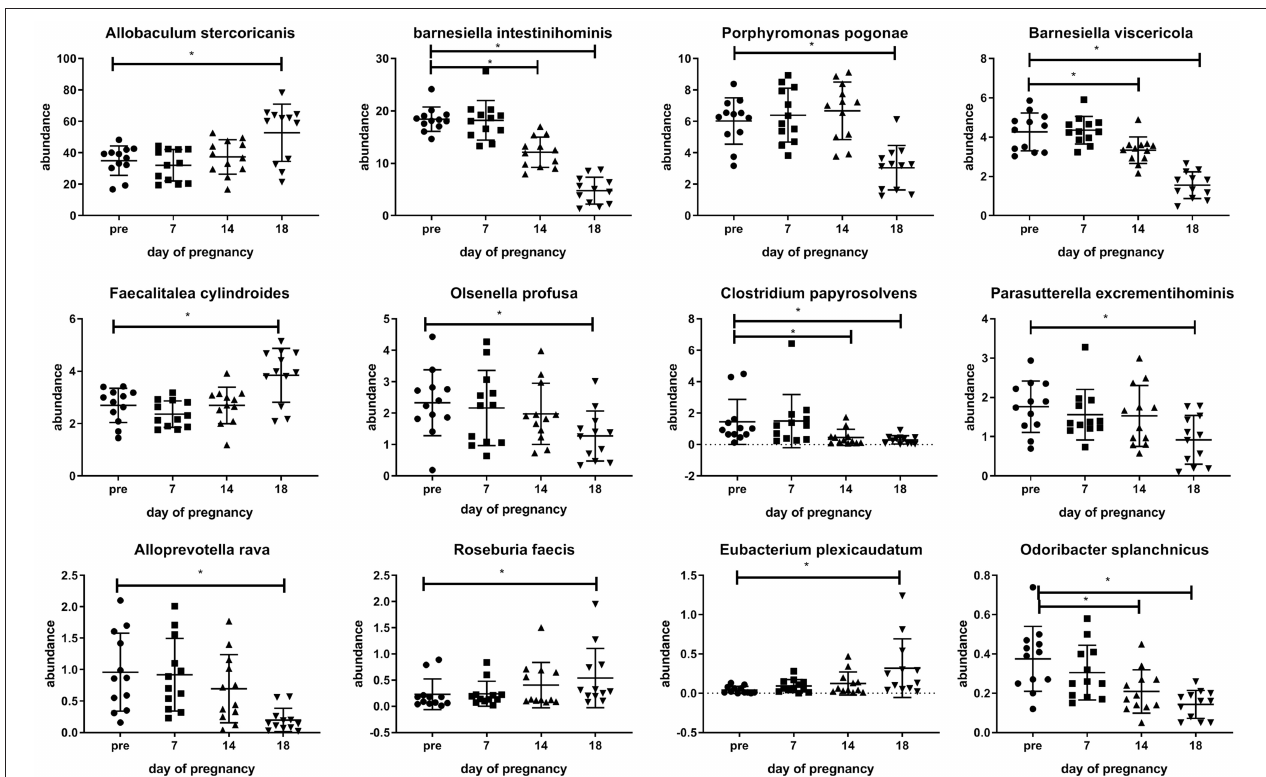
FIGURE 4 | Changes observed in the abundance of various microbiota species in the feces of conventional mice measured pre-pregnancy (pre) and during pregnancy at days 7, 14, and 18. *Significantly different from pre-pregnancy (Friedman’s test, followed by Dunn’s post-test, p < 0.05).